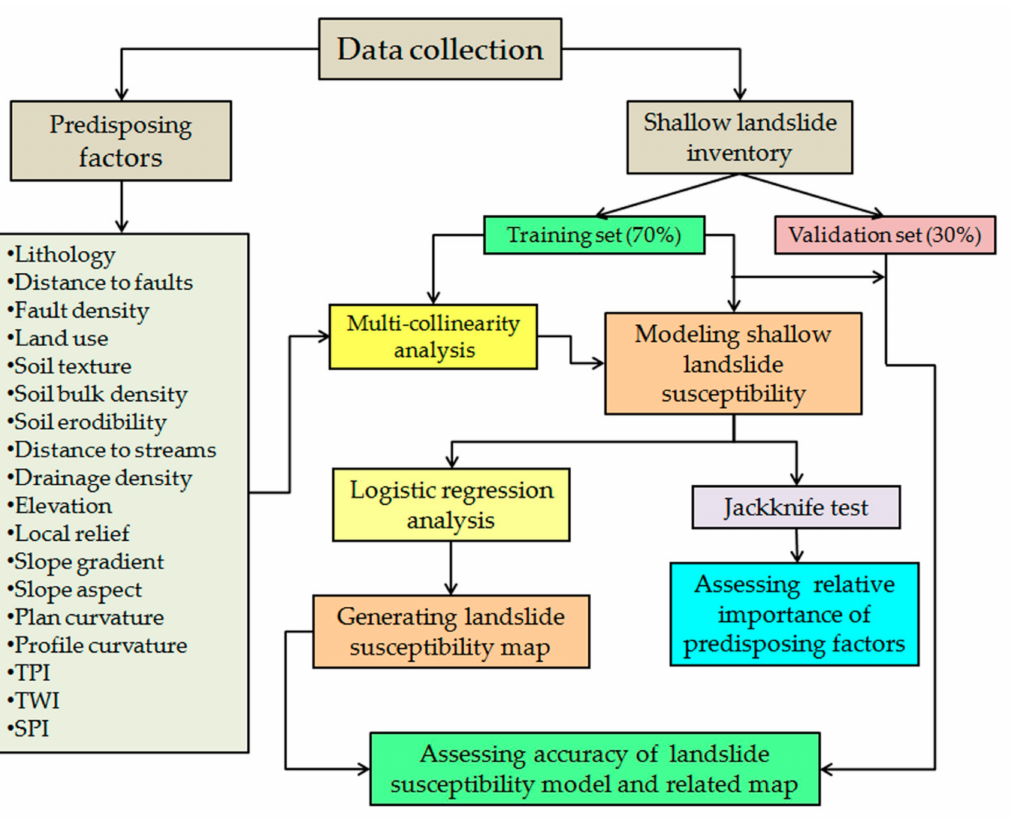
Figure 2. Schematic flowchart adopted in the current